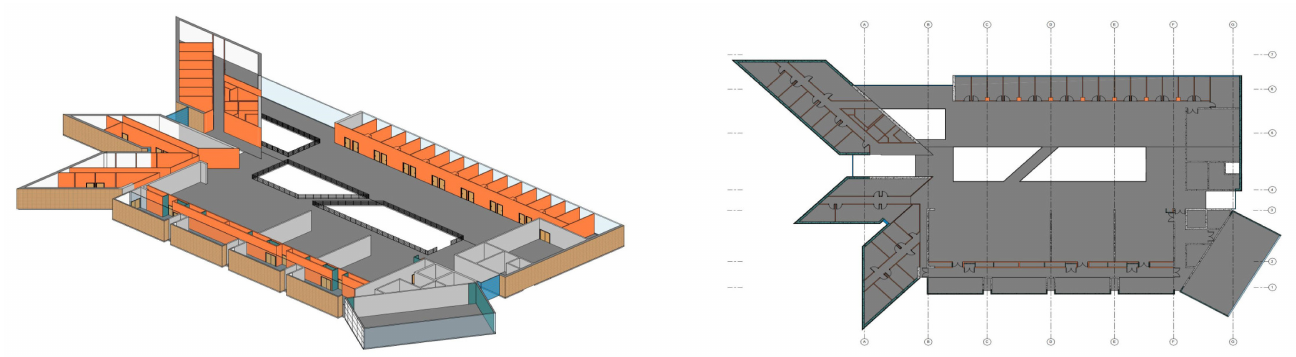
Figure 2. TETB images showing the thermal state, students’ activities, and the façade design.